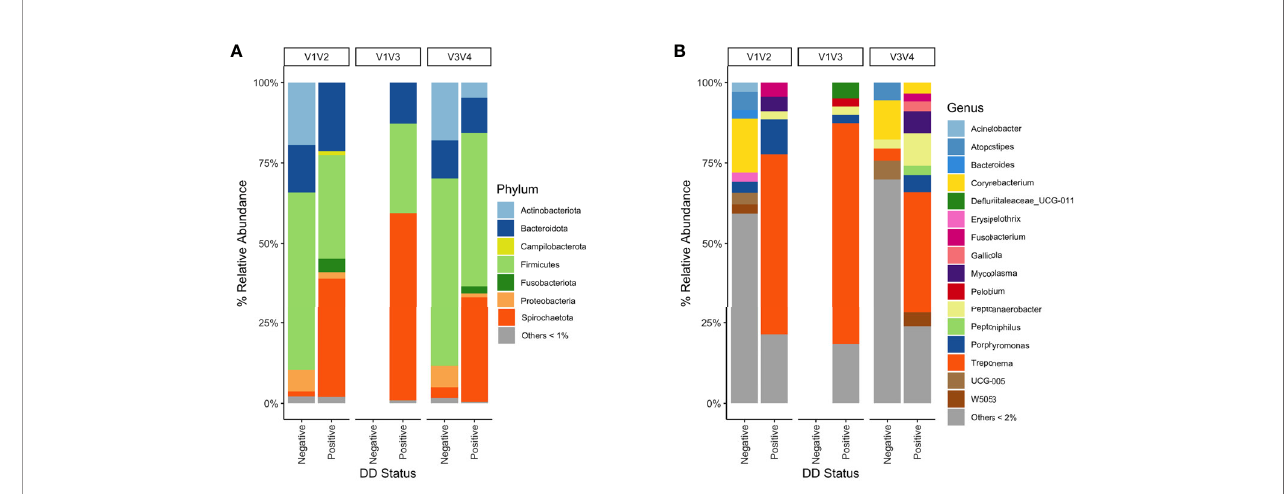
FIGURE 5 | Mean percent relative abundance of DD negative skin and DD lesions from 16S rRNA hypervariable regions V1V2, V1V3, and V3V4. (A) Taxa were grouped at the phylum level, and all taxa that had less than 1% relative abundance were grouped. Taxa were grouped at the (B) genus level, and all taxa that had less than 2% relative abundance were